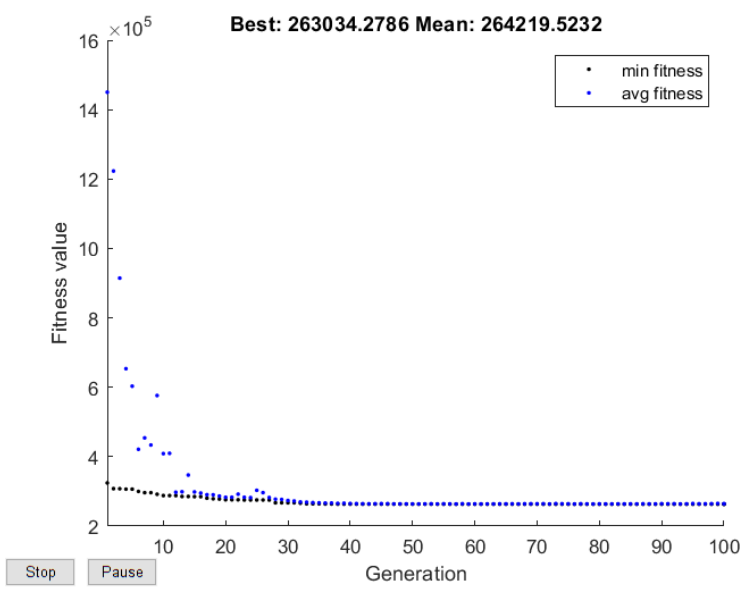
Figure 19. Best and average fitness evolution in control strategy #4 when minimizing V ovf . Table 13. Simulation results when the volume of overflow is minimized (strategy #4).